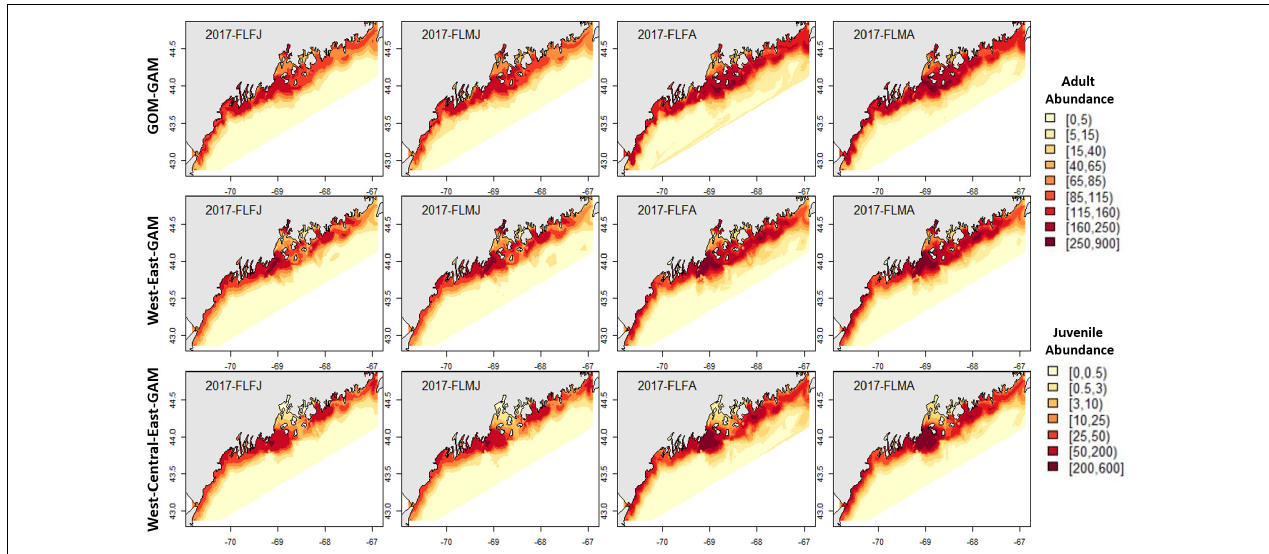
FIGURE 4 | 2017 Fall American lobster estimated spatial distribution. Legend colors increase in abundance estimates from pale yellow to dark red. Each column represents a season × sex × size group. Each row represents the modeling approach used to generate the abundance estimations. Adult abundance legend corresponds with adult lobster group estimates. Juvenile abundance legend corresponds with juvenile lobster group estimates.